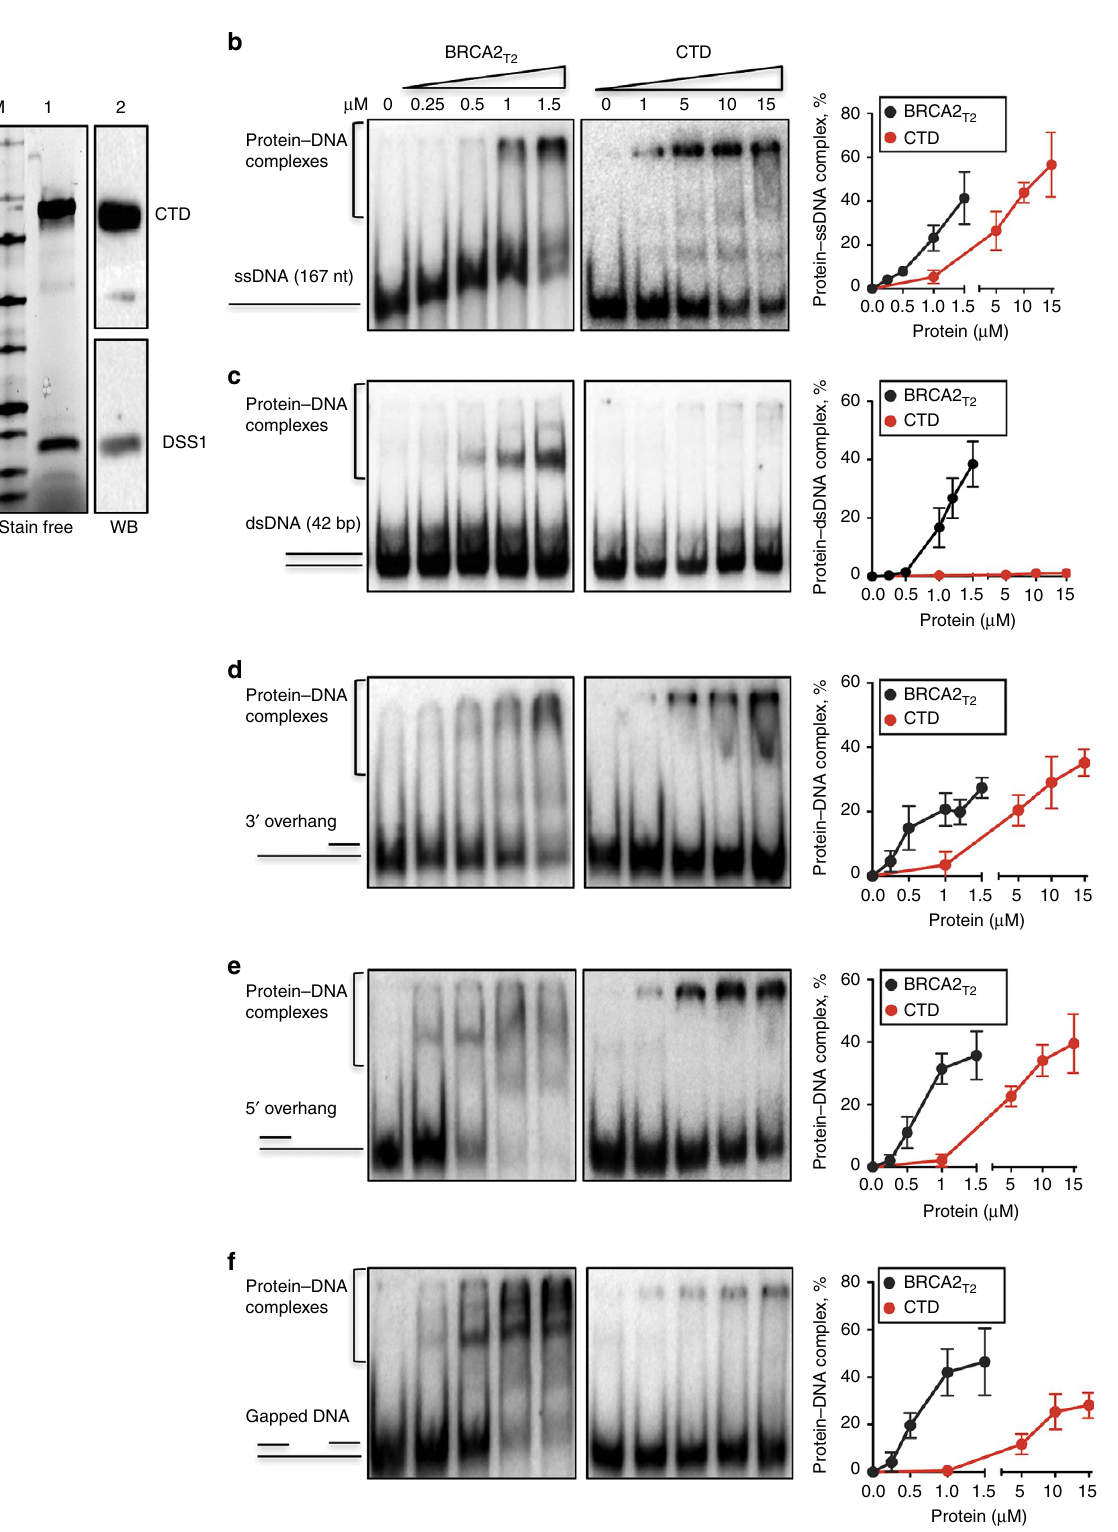
Figure 2 | BRCA2 T2 binds to different DNA substrates and with stronger affinity than CTD. ( a ) M size markers. (1) SDS–PAGE showing purified CTD (5 m g) loaded in a 4–15% acrylamide gel. (2) Western blot of the gel shown with an antibody against the His tag of the CTD and an antibody specific to DSS1 protein co-purified with it. ( b ) EMSA and quantification comparing the binding of BRCA2 T2 and CTD to ssDNA (167mer). ( c ) dsDNA (40mer), ( d ) 3’ ssDNA overhang, ( e ) 5’ ssDNA overhang, ( f ) gapped DNA. Error bars, s.d. ( n ¼